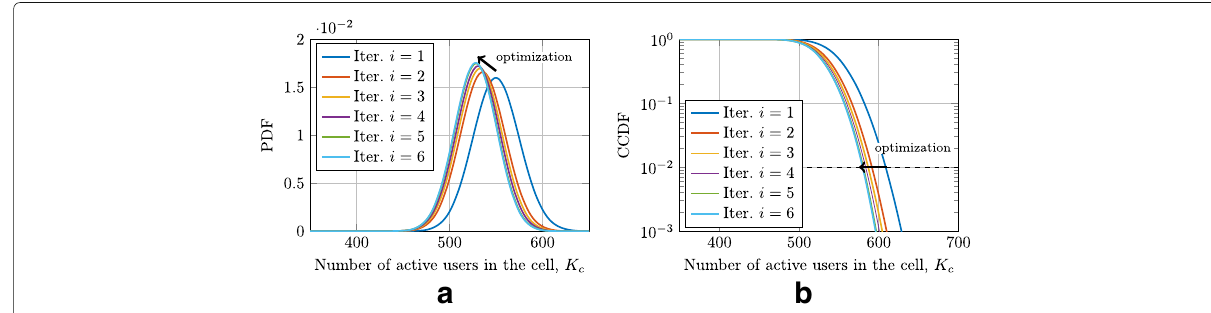
Fig. 7 Pilot-based optimization. Example of the pilot-based optimization for K max = 64 users. a PDF and b CCDF